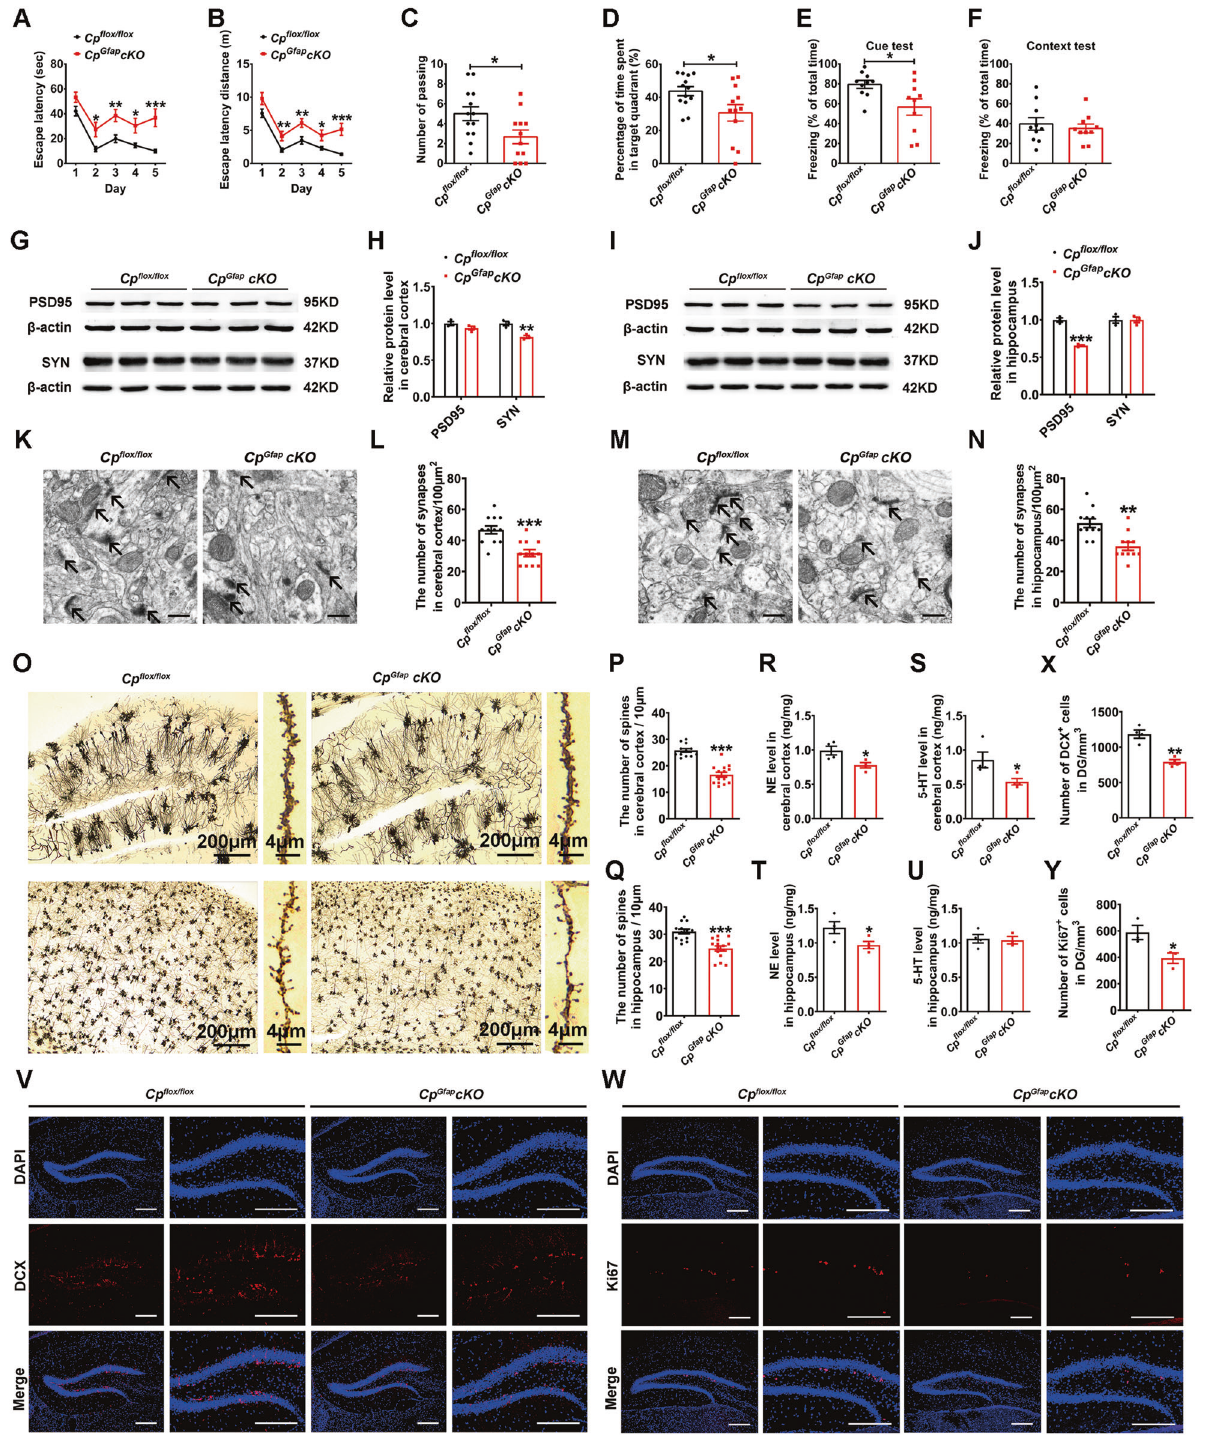
cortex and hippocampus, and observed that the percentage of GFAP + L-ferritin + cells and the ratio of GFAP + L-ferritin + / GFAP + were decreased in the hippocampus of Cp Gfap cKO mice compared to Cp fl ox/ fl ox mice (Fig. 3R, T-V), while the proportions of these cells did not change in the cerebral cortex (Fig. 3Q, S, U, V). Next, we immunostained Iba-1 (microglia marker) and L-ferritin, and found that in both cortical and hippocampal areas, the percentage of Iba-1 + L-ferritin + cells and the ratio of Iba-1 + L-ferritin + / Iba-1